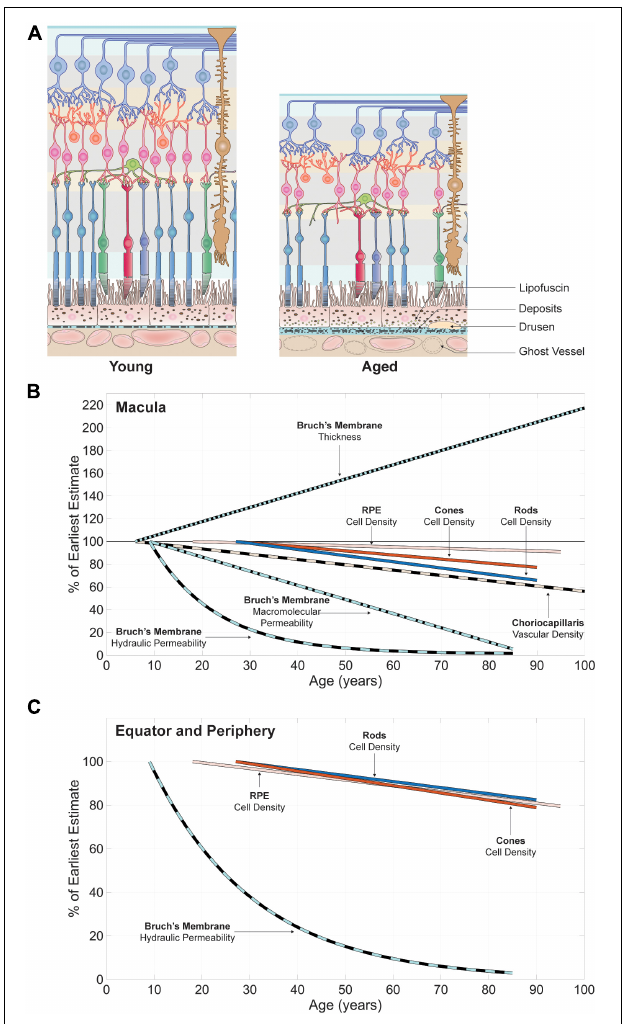
FIGURE 5 | Age-related variations in retinal neuron populations and in the key structures of their respective metabolite delivery systems in the macula and equator and periphery. A schematic of changes affecting the retina and choroid adapted and modified with permission from Campello et al. (2021) is shown in (A) . Linear and non-linear regressions were collected from publications listed in Supplementary Table 2 . The features plotted are normalized by the first value of each regression, which corresponds to the estimate in the youngest eye included in each study. In the macula (B) , there can be large inter-individual differences that mask variations in the density of RPE cells and cone photoreceptors with age. With careful elimination of disease and other extraneous variables, some older subjects have significantly lower cone densities than do younger subjects. Aging is associated with an increase in the thickness of Bruch’s membrane and a reduction in its hydraulic and macromolecular permeability. The rate of rod loss and the decrease in the vascular density of the choriocapillaris observed with age lie within a similar range. In the equatorial and peripheral region (C) loss of cones with age is more pronounced as compared to